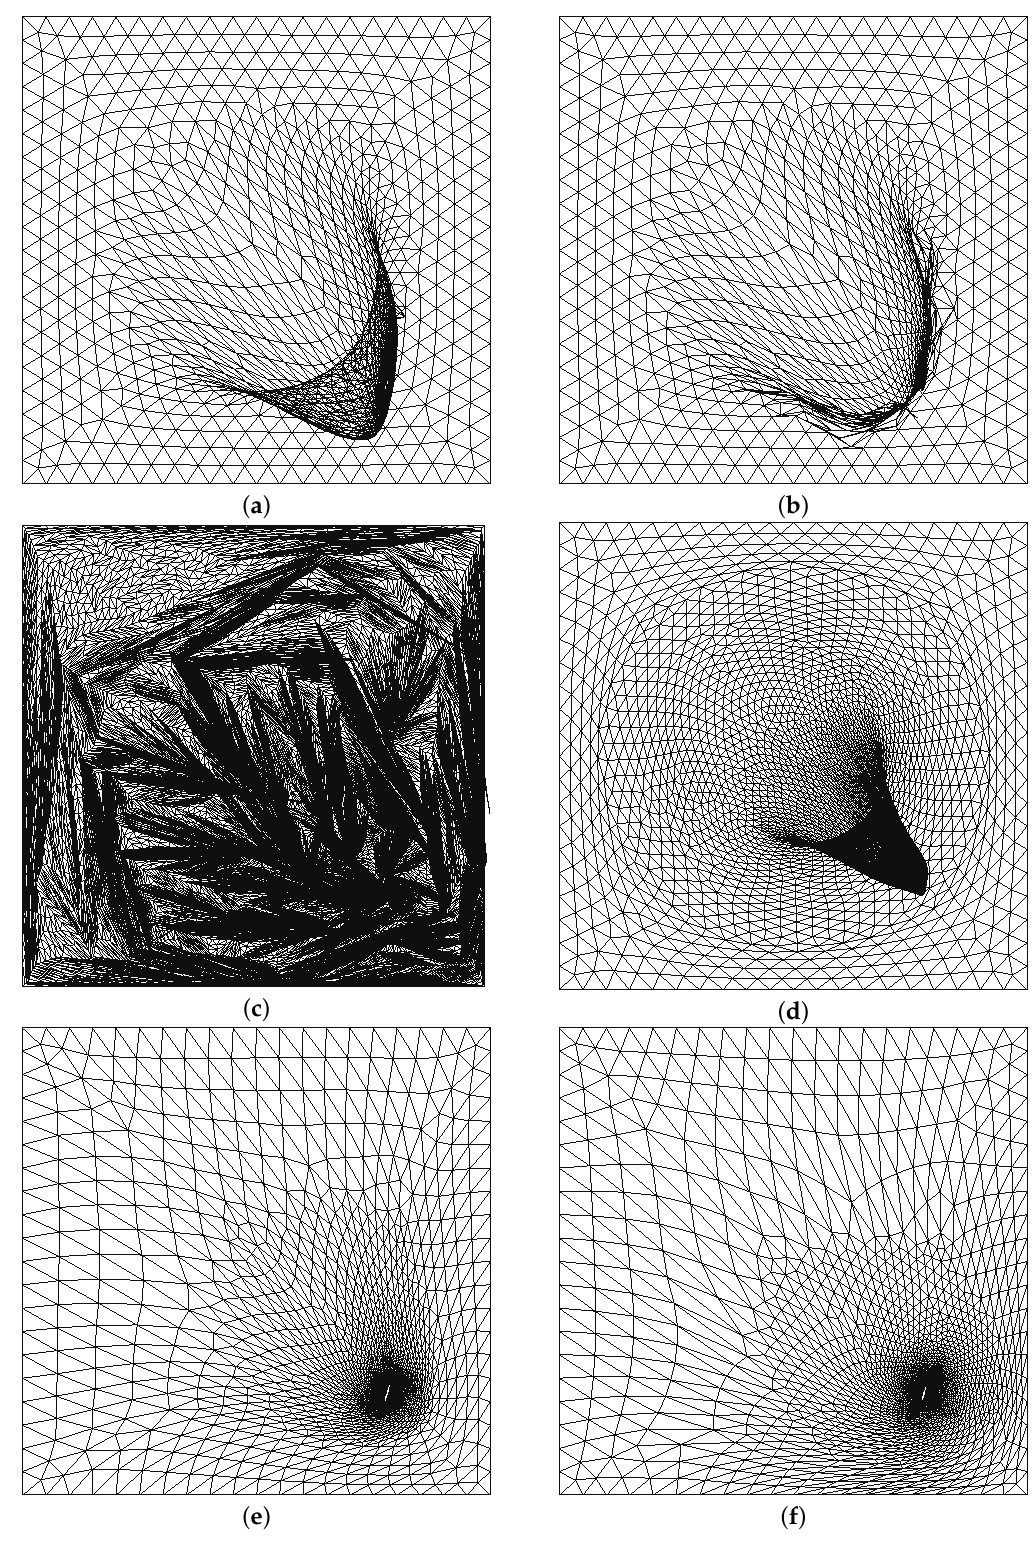
Figure 7. ( a ) Initial deformed mesh with 459 inverted elements. ( b ) Optimized mesh using the Untangle-Beta untangler. ( c ) Optimized mesh using the Size untangler. ( d ) Optimized mesh using the Shape-Size untangler. ( e ) Optimized mesh using the proposed approach. ( f ) Optimized mesh using the proposed approach and the Shape Improve